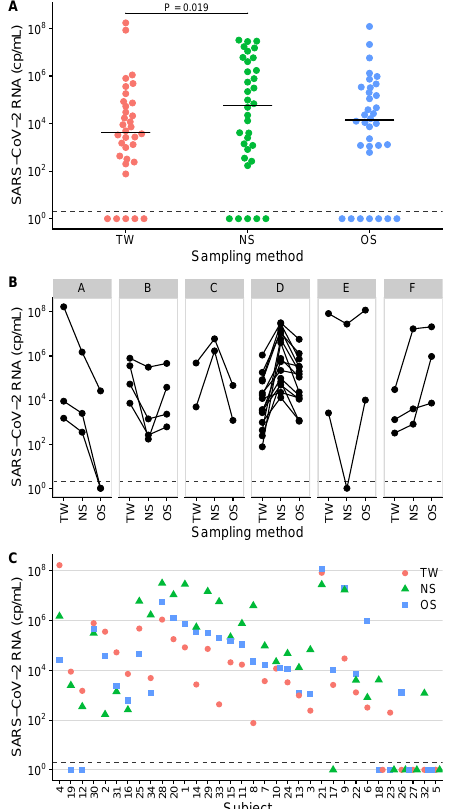
Figure 1. SARS-CoV-2 RNA concentrations in samples of 34 study participants. Measurements are separated into sampling site groups (TW, throat washing; NS, nasopharyngeal swab; OS, oropha- ryngeal swab). Samples with the result not detected were set to 10 0 cp/mL and are plotted below the dashed lines. ( A ) Levels of SARS-CoV-2 viral loads across sampling sites. The respective median concentrations are shown as horizontal lines. The statistically significant difference between the groups was assessed by post-hoc tests based on the linear mixed-effects model and is indicated by a horizontal line with the corresponding P value < 0.05 on top of the data panels. ( B ) Concentration patterns A–F as found by combinatorial analysis of the quantitative results. Data from six subjects with ≤ 1 positive result are not shown. ( C ) comparative SARS-CoV-2 RNA quantification plots, sorted by concentration pattern and decreasing median viral load. Subject identification numbers are indicated on the